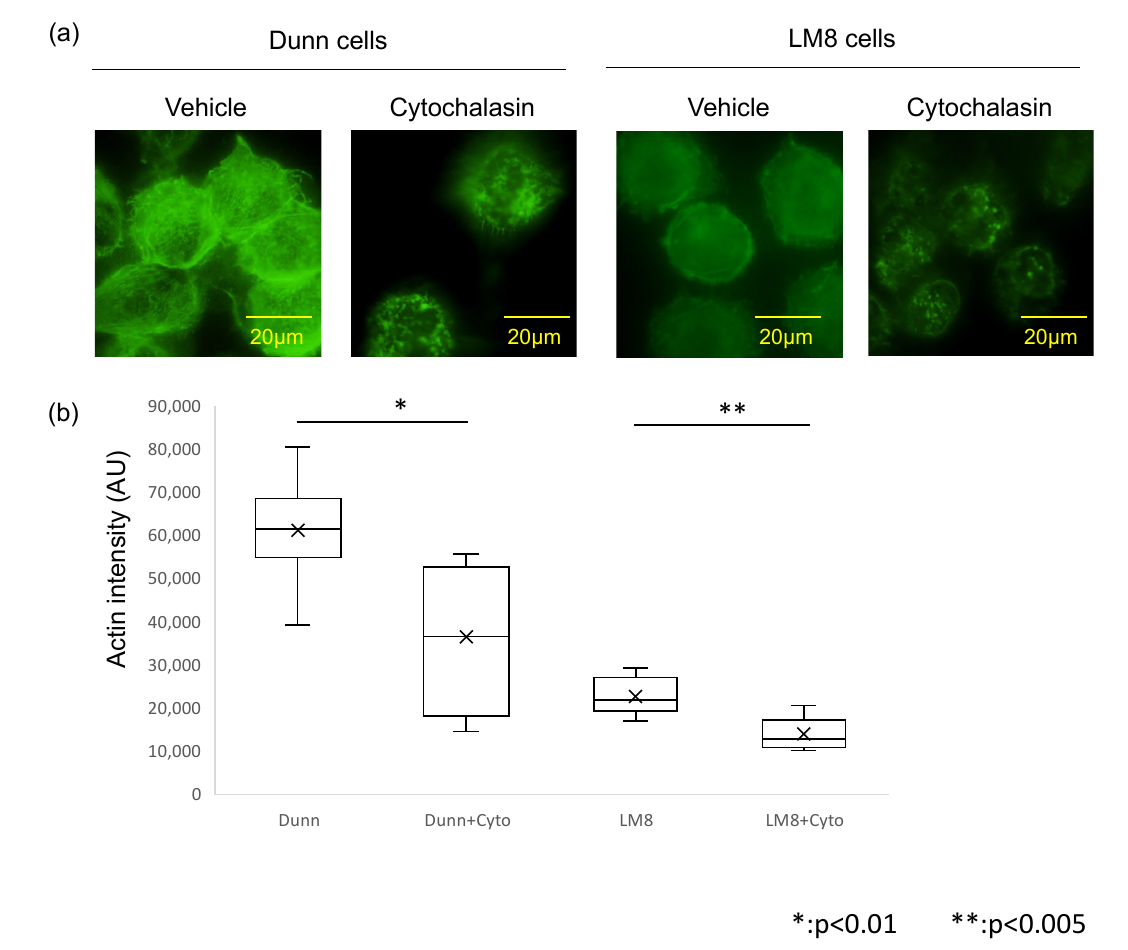
Figure 4. Actin polymerization and intensity with or without cytochalasin. ( a ) Actin filaments were visualized and compared between Dunn ( left ) and LM8 ( right ) with or without cytochalasin. ( b ) Actin intensity was evaluated between Dunn and LM8 with or without cytochalasin.